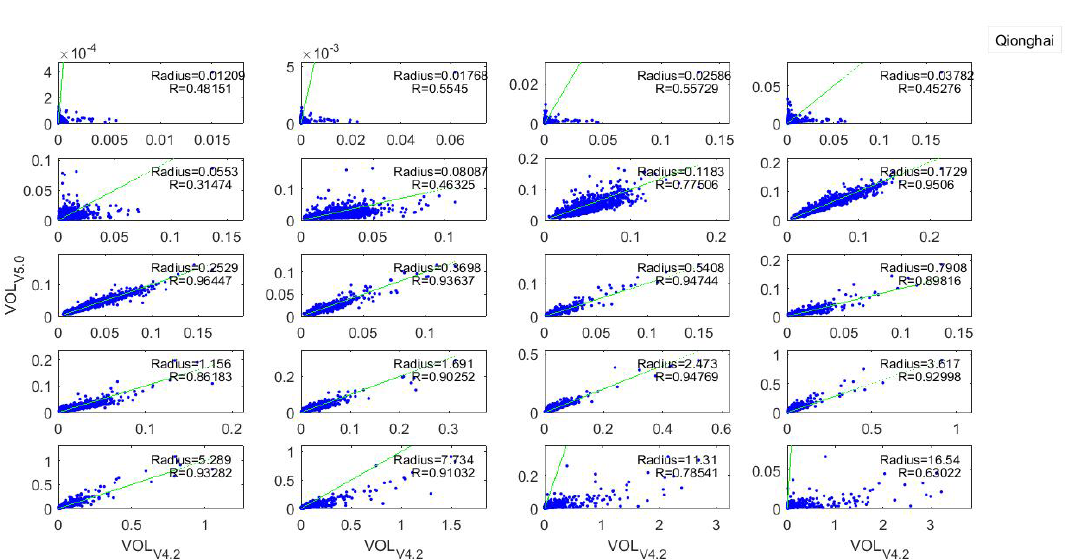
Figure 4. Scattergrams of volume size distribution retrieved by SKYRAD V4.2 and V5.0 in 20 bins over Qionghai during February 2013 to December 2015. Only data with AOD 500nm >0.2 are shown. The green line indicates the fitted linear regression curve.